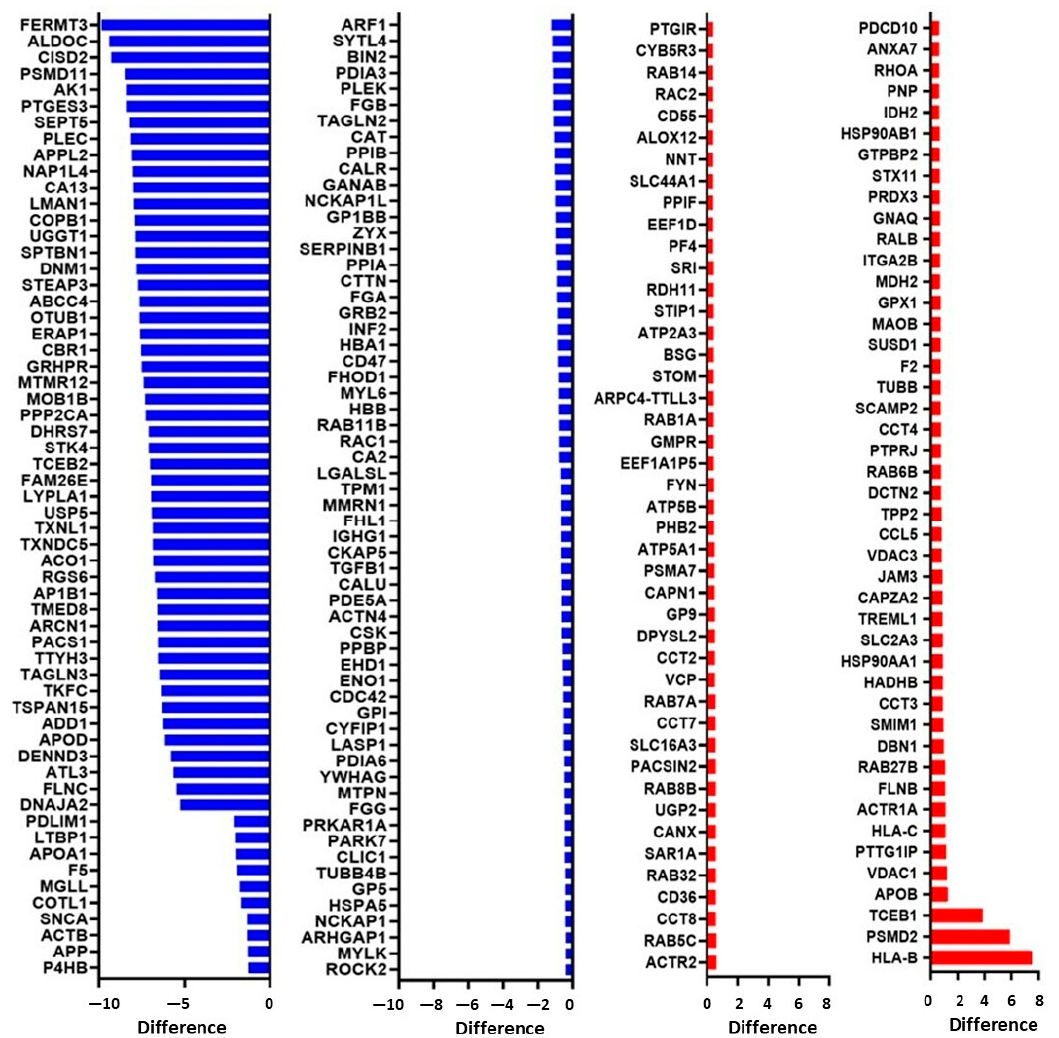
Figure 10. LC-MS/MS analysis of platelet-derived EVs obtained from CRC patients, and healthy controls revealed 208 significantly modulated proteins. The different levels of the 208 significantly modulated proteins are reported. The blue bars represent the 119 decreased proteins in CRC, and the red bars show the 89 significantly increased proteins in CRC compared to the control.